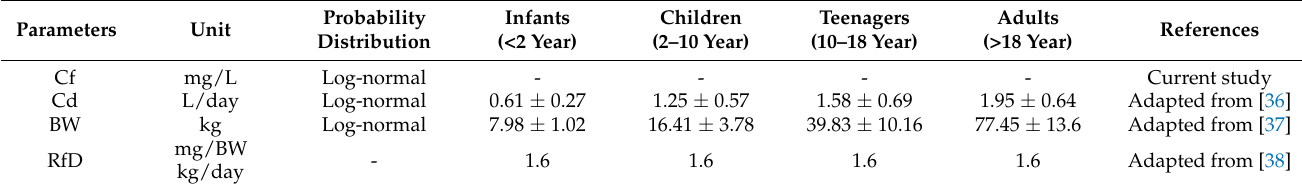
Table 1. Parameters used for health risk assessment in groundwater of Hormozgan province coun- ties,